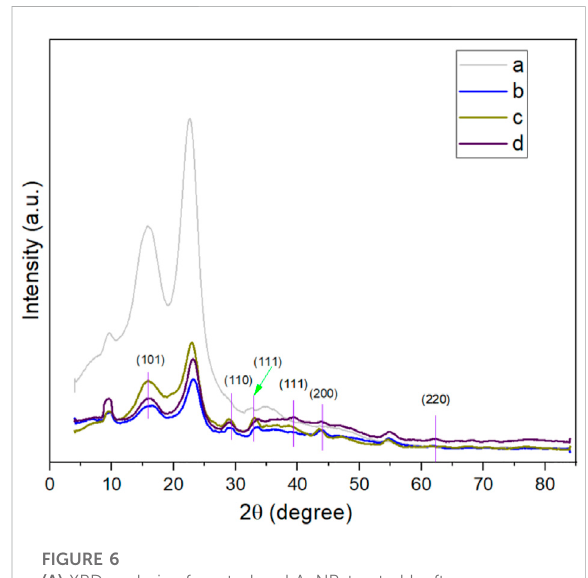
FIGURE 6 (A) XRD analysis of control and AgNP-treated kraft papers.